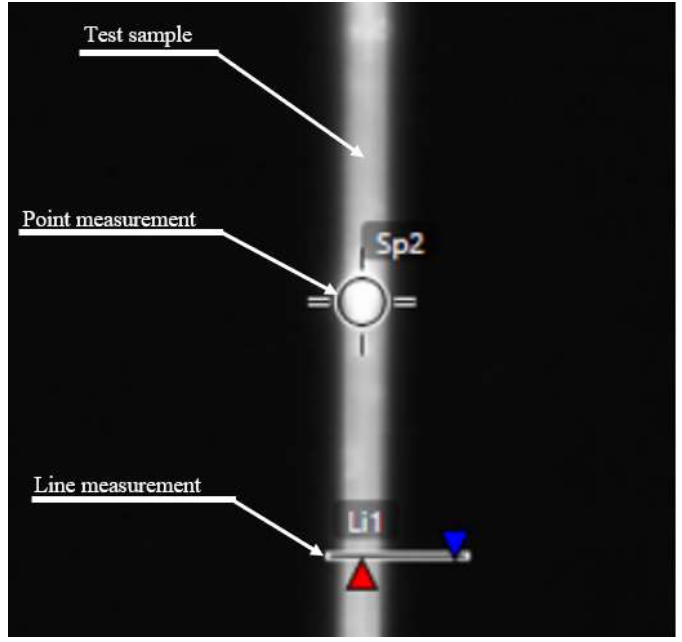
Figure 4. Methodology for the thermographic measurements.